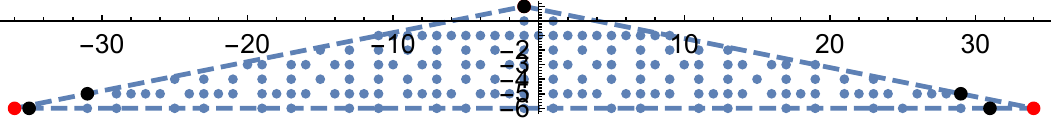
Figure 4. The toric fan (arrows indicating rays are simpli(cid:12)ed to points for clarity) of the base of a generic model with large h 1 ; 1 f 416,14, f -12,-1,-2,-2,-3,-1,-5,-1,-3,-2,-2, (cid:0) 1 ,-11, (cid:0) 1 ,-2,-2,-3,-1,-5,-1,-3,- 2,-2,-1,-12//-12//-12//-12//-12//-12//-12//-12//-12//-12//-12, (cid:0) 1 ,-2,-2,-3,-1,-5,-1,-3,-2, (cid:0) 1 ,-8,-1,- 2,-3,-2,-1,-8, 0 g , where the (cid:12)ve curves corresponding to vertices of the base are in boldface, and are denoted by black dots in the fan diagram. The point at the top ( (cid:0) 1 ; 1) corresponds to the zero curve, which is also a vertex of r . Two red dots in the fan diagram correspond to points in the tops: pt (6) 1 of D B 13 and pt 00 of D B 153 , respectively; these points thus do not correspond to rays of the base fan. 1 In the (cid:12)rst model, the top over the (cid:12)rst (cid:0) 8-curve ( D ) is f pt 0000 ; pt 000 ; pt 00 ; pt 00 ; pt 0 g B 156 1 2 3 4 5 while over the second ( D ) is f pt 0000 ; pt 000 ; pt 00 ; pt 00 ; pt 0 ; pt 0 g ; in the second model, B 162 1 2 3 4 5 6 it is f pt 0000 ; pt 000 ; pt 00 ; pt 00 ; pt 0 g over both (cid:0) 8-curves; however there is no model of 1 2 3 4 5